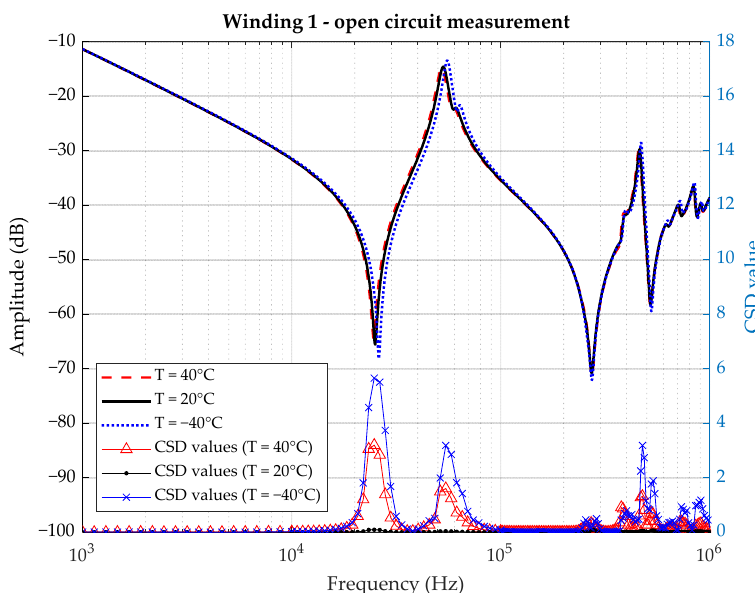
◦ C, 20 ◦ C and − 40 ◦ C.